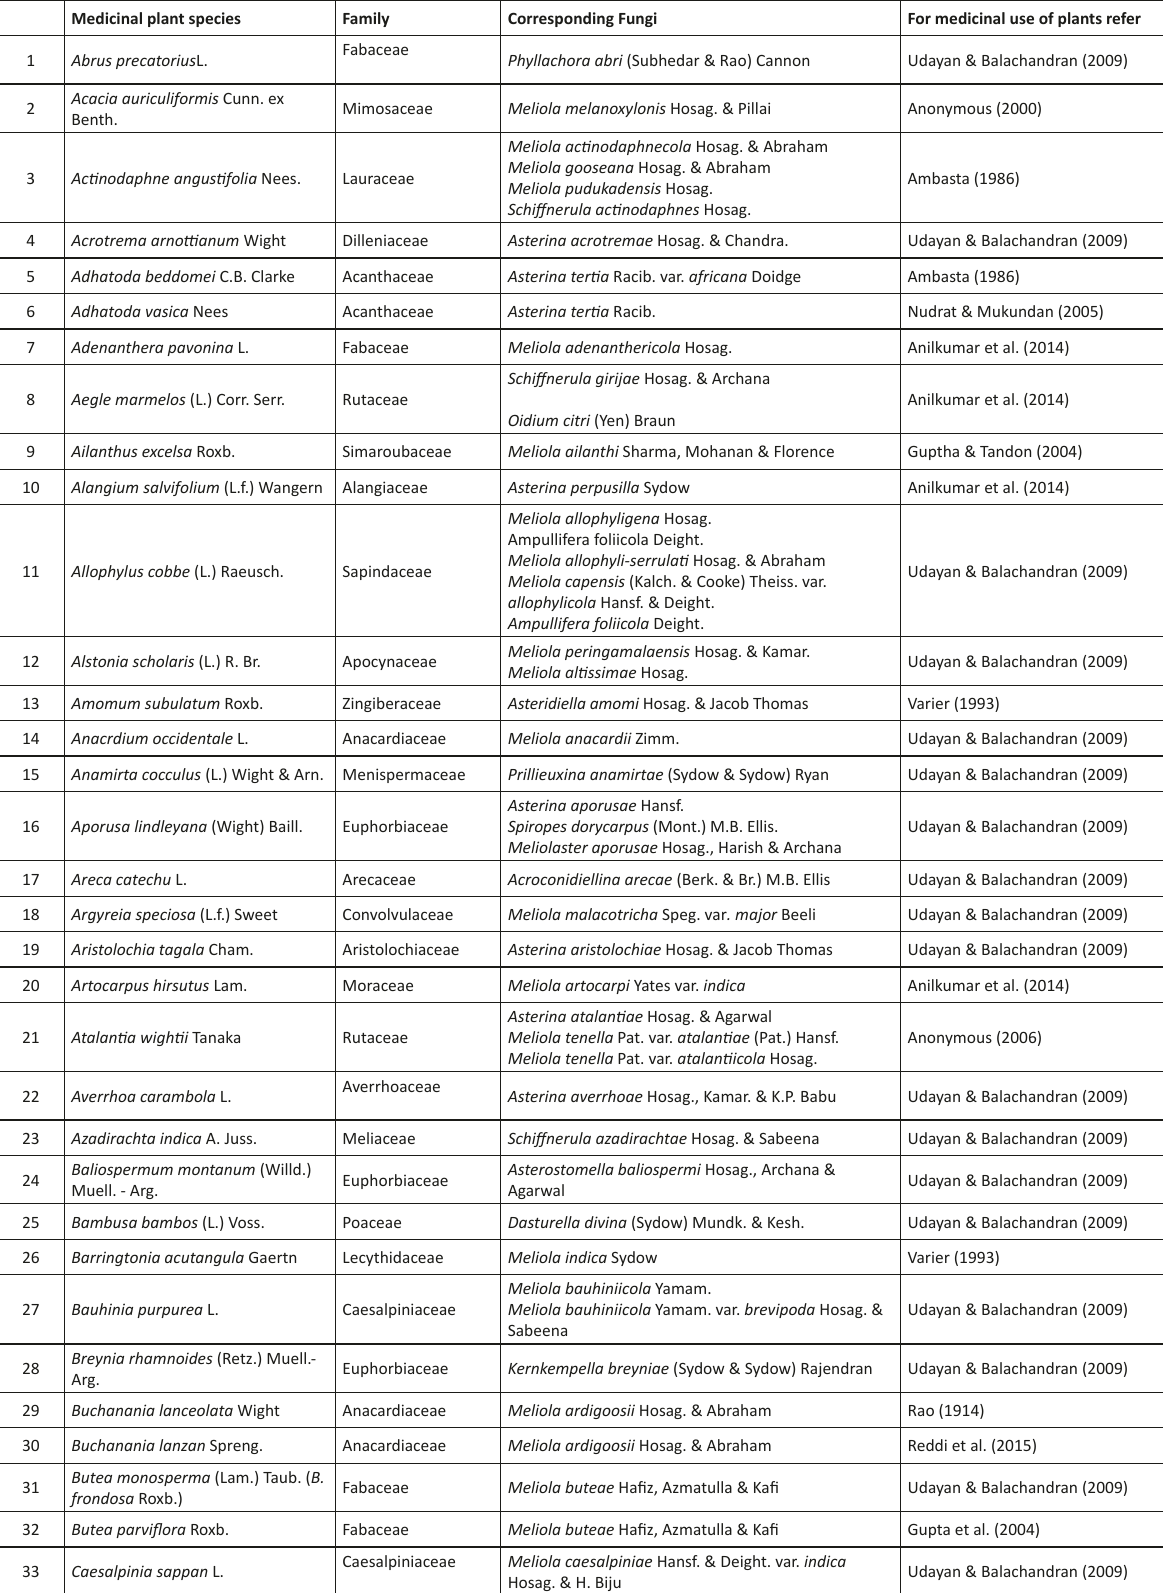
Table 1. Host medicinal plants and corresponding fungi with references to the medicinal plant